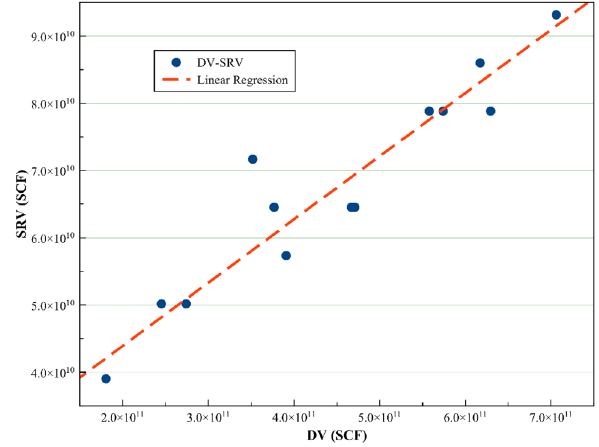
Fig. 13 SRV–DV linear